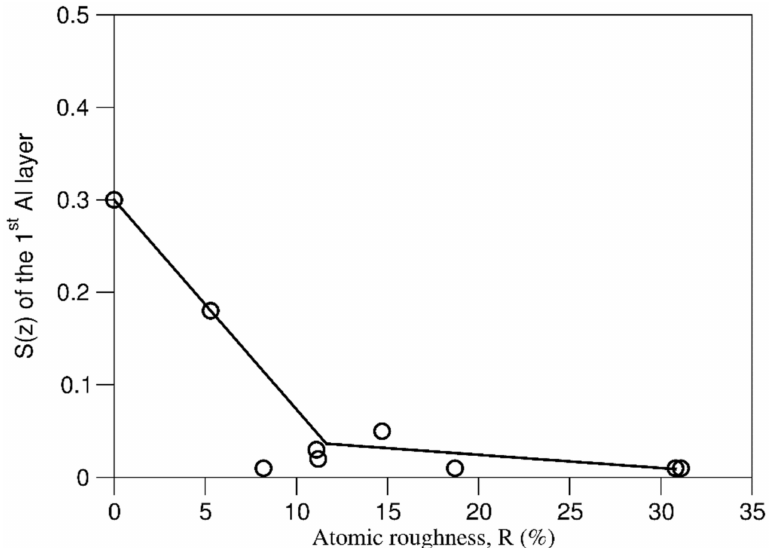
Figure 11. Atomic ordering coefficient decreases sharply with increasing atomic roughness of the substrate surface. Dependence of the atomic ordering coefficients, S (z) on the atomic roughness, R of the 1st Al layer at the Al( l )/oxide